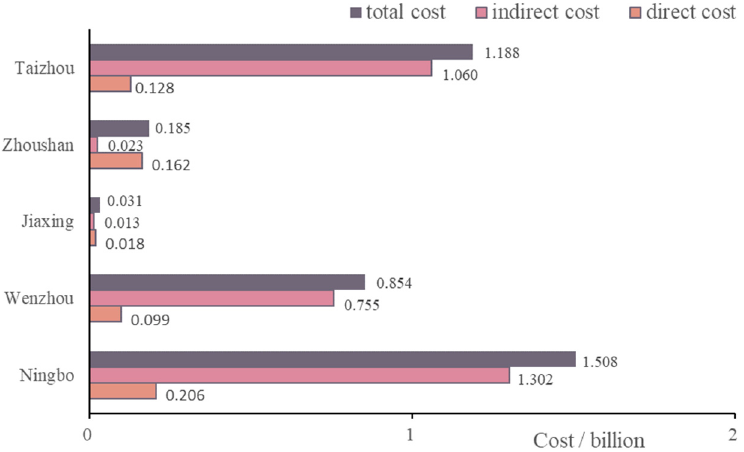
Figure 4. The initial costs including both direct and indirect cost invested in the project by the five coastal cities of Zhejiang (Wenzhou, Taizhou, Ningbo, Jiaxing and